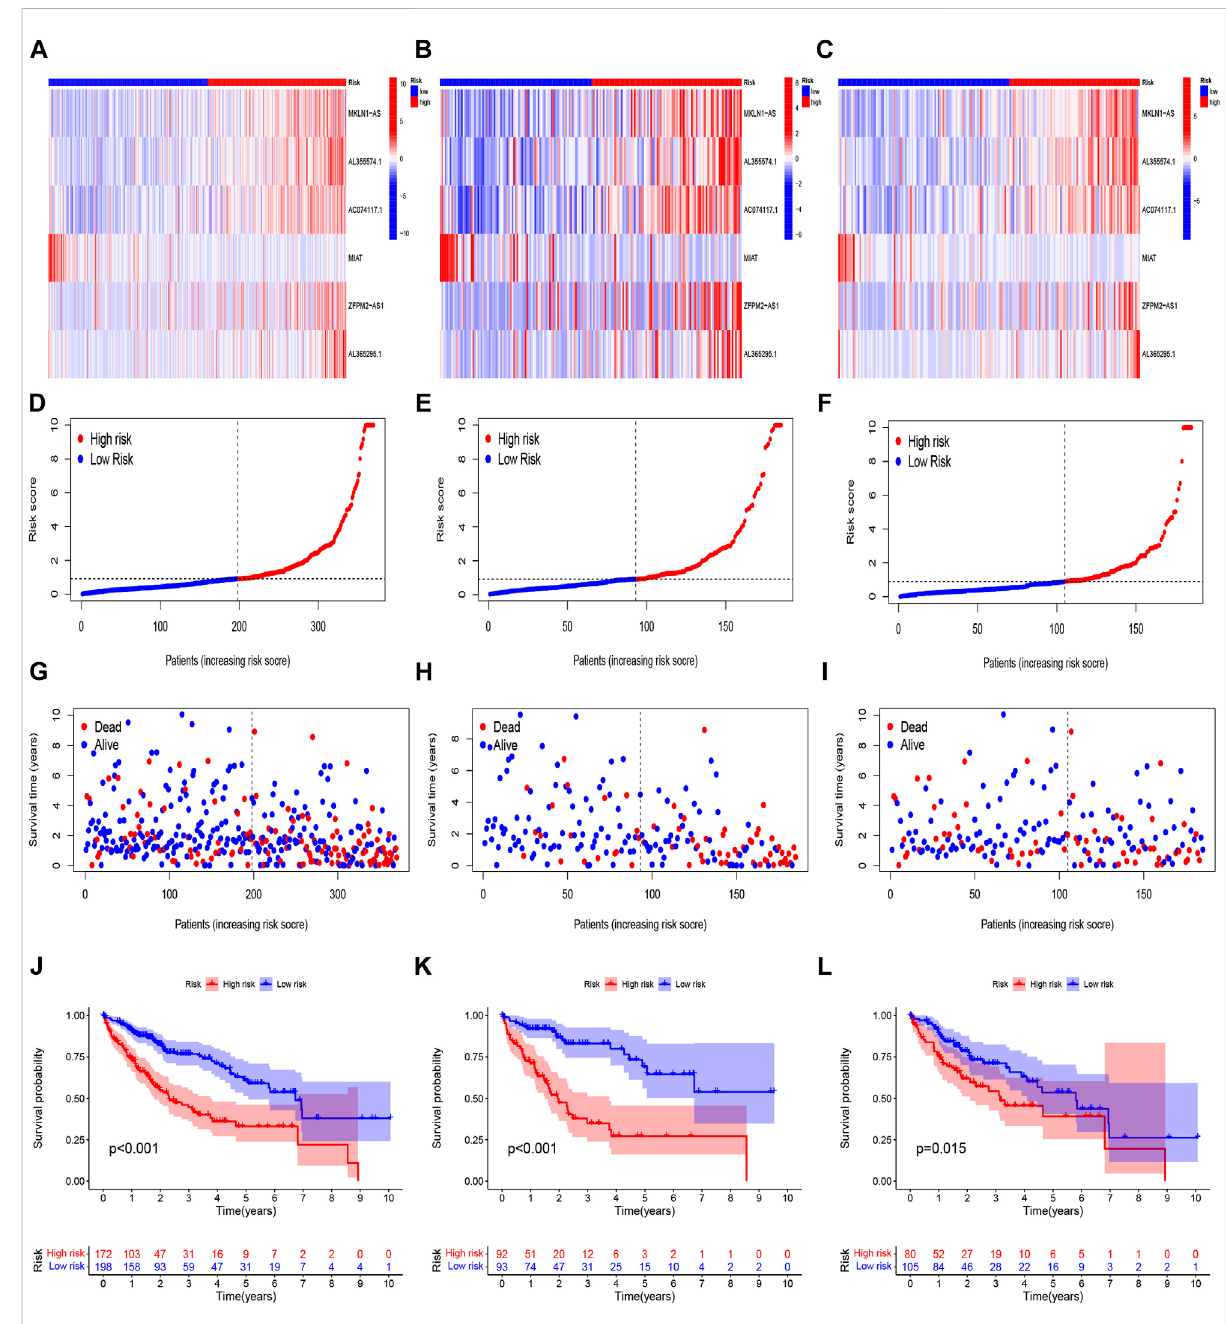
risk score with clinical characteristics such as age, gender, stage, and tumor stage. Correction curves based on the Hosmer- Lemeshow test were used to show the consistency between the actual outcome and the model prediction outcome. enriched pathways. The statistical signi fi cance criteria were set at p